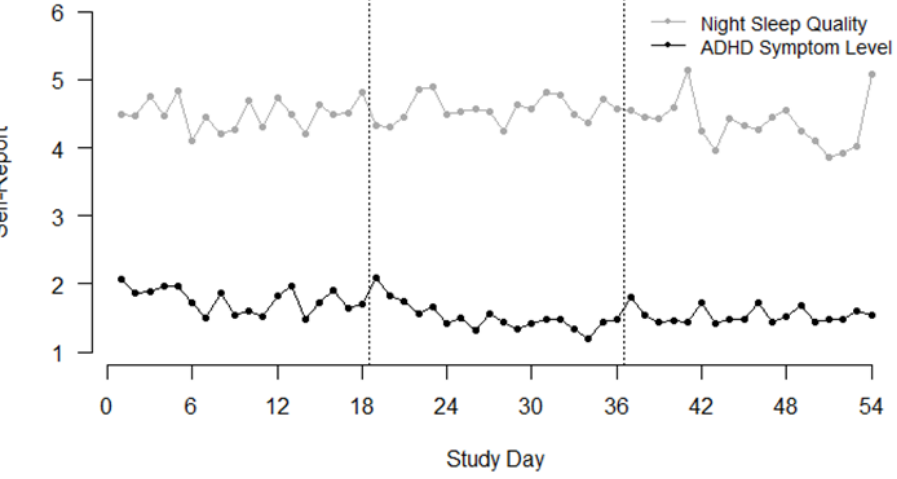
Figure 2. Time course of self-reported night sleep quality and ADHD symptom levels (in the afternoon) across all 54 study days; The dashed lines indicate breaks between each burst.